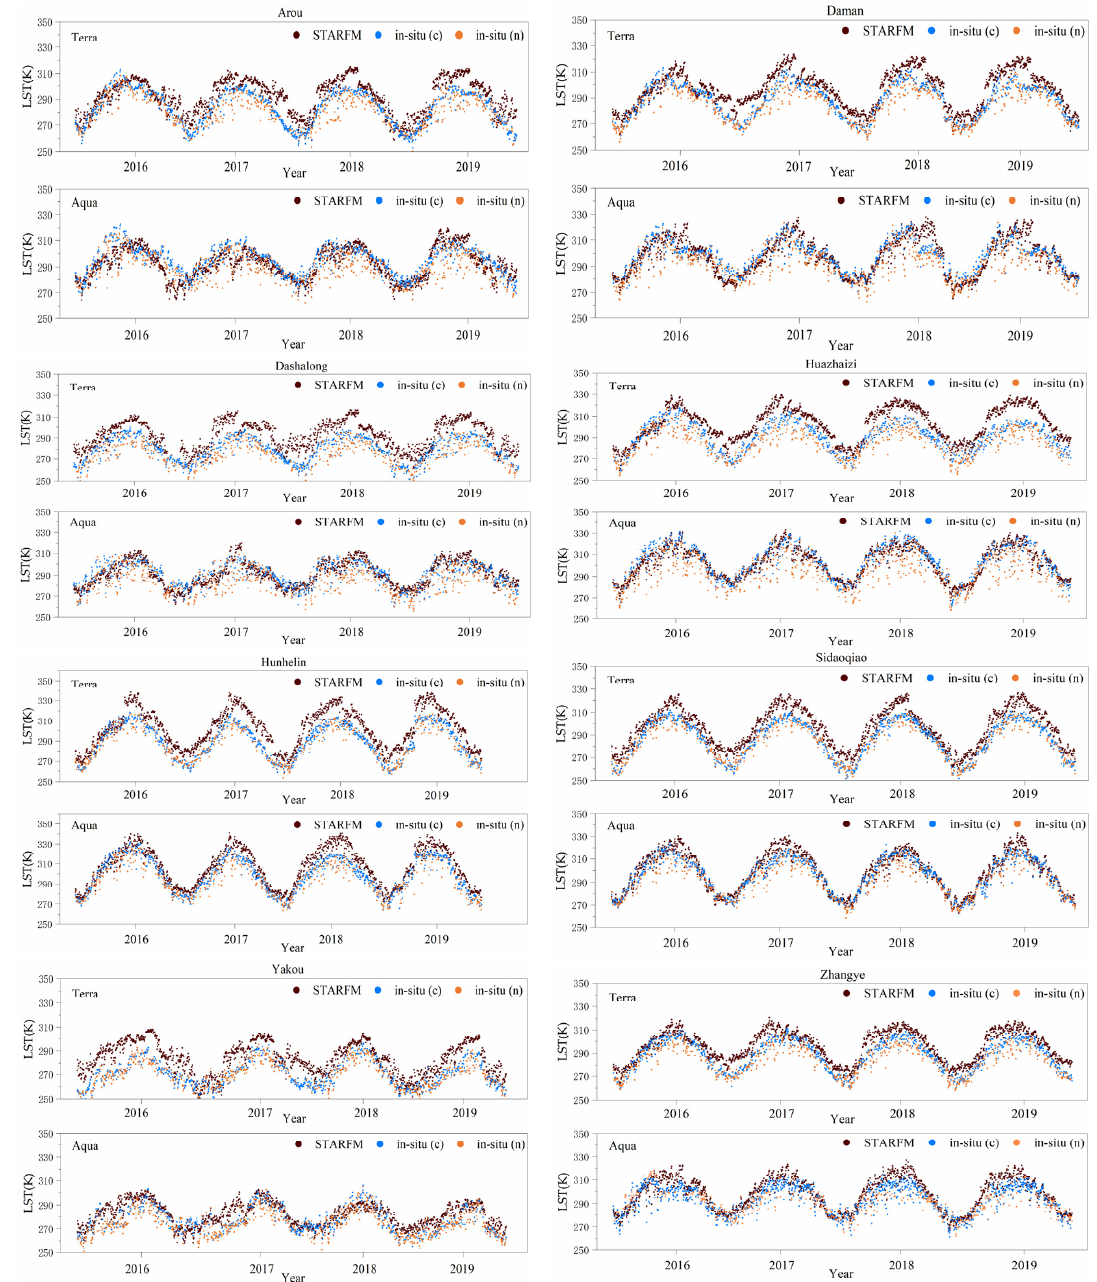
Figure 5. Comparison of reconstructed LST using STARFM with LST measured by AWS at 8 sites from 2016 to 2019. in situ (n) indicates the measured LST with cloudy skies at the observation station; in situ (c) indicates the measured LST with clear skies at the observation station.